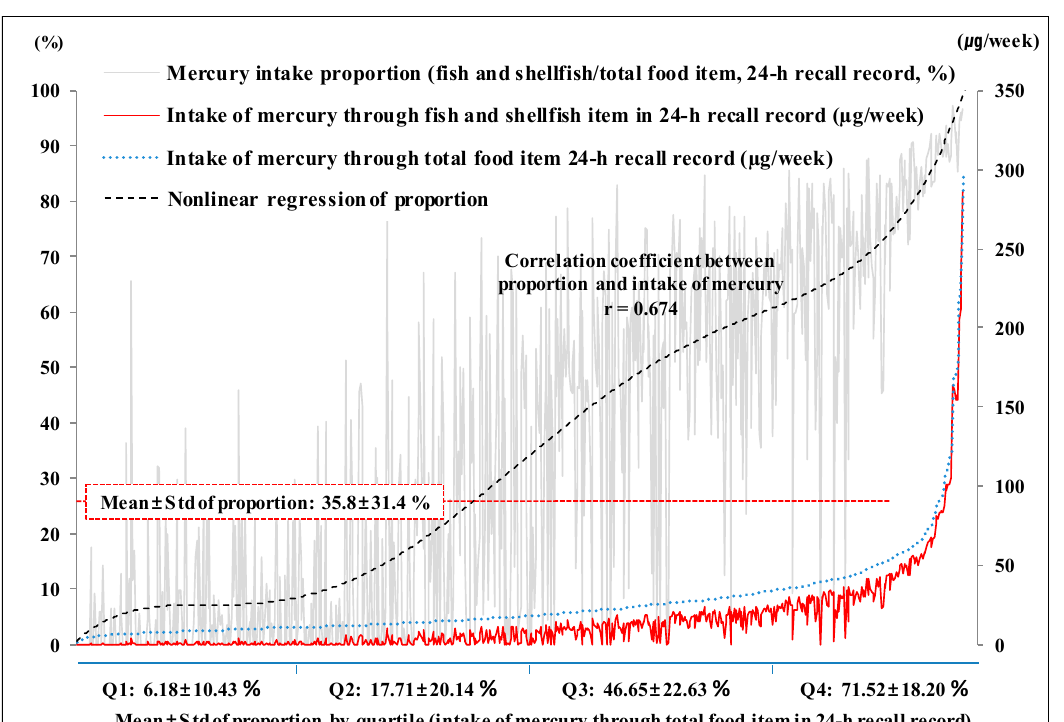
Figure 1. Mercury intake proportion from fish and shellfish items in a 24-h recall record. Q1–Q4: categorization by quartile according to the total mercury intake; Q1: 1.285–10.935 µg/week, Q2: 10.939–17.490 µg/week, Q3: 17–528–30.931 µg/week, Q4: 31.024–295.803 µg/week.